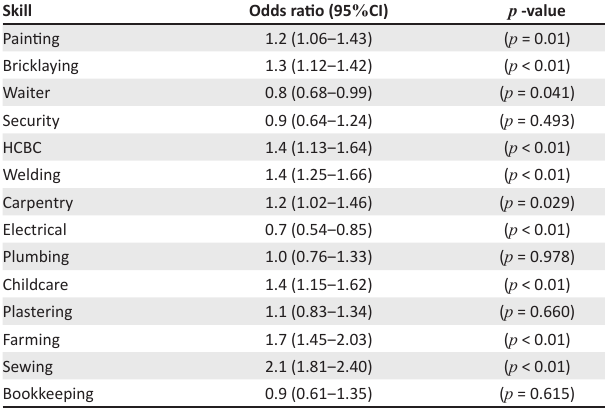
TABLE 2: Odds ratios for skills.